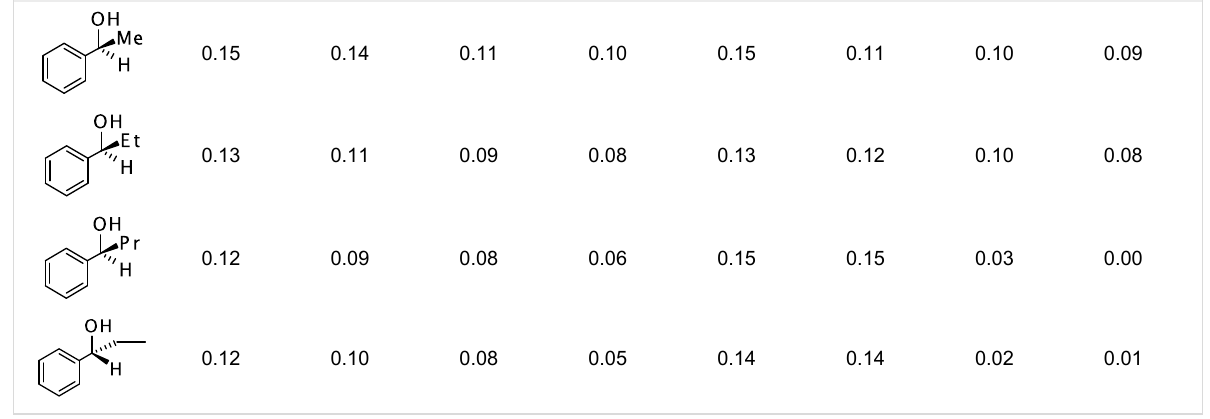
Table 2: Chemical shifts of the methyls of trimethylsilyls substituents.